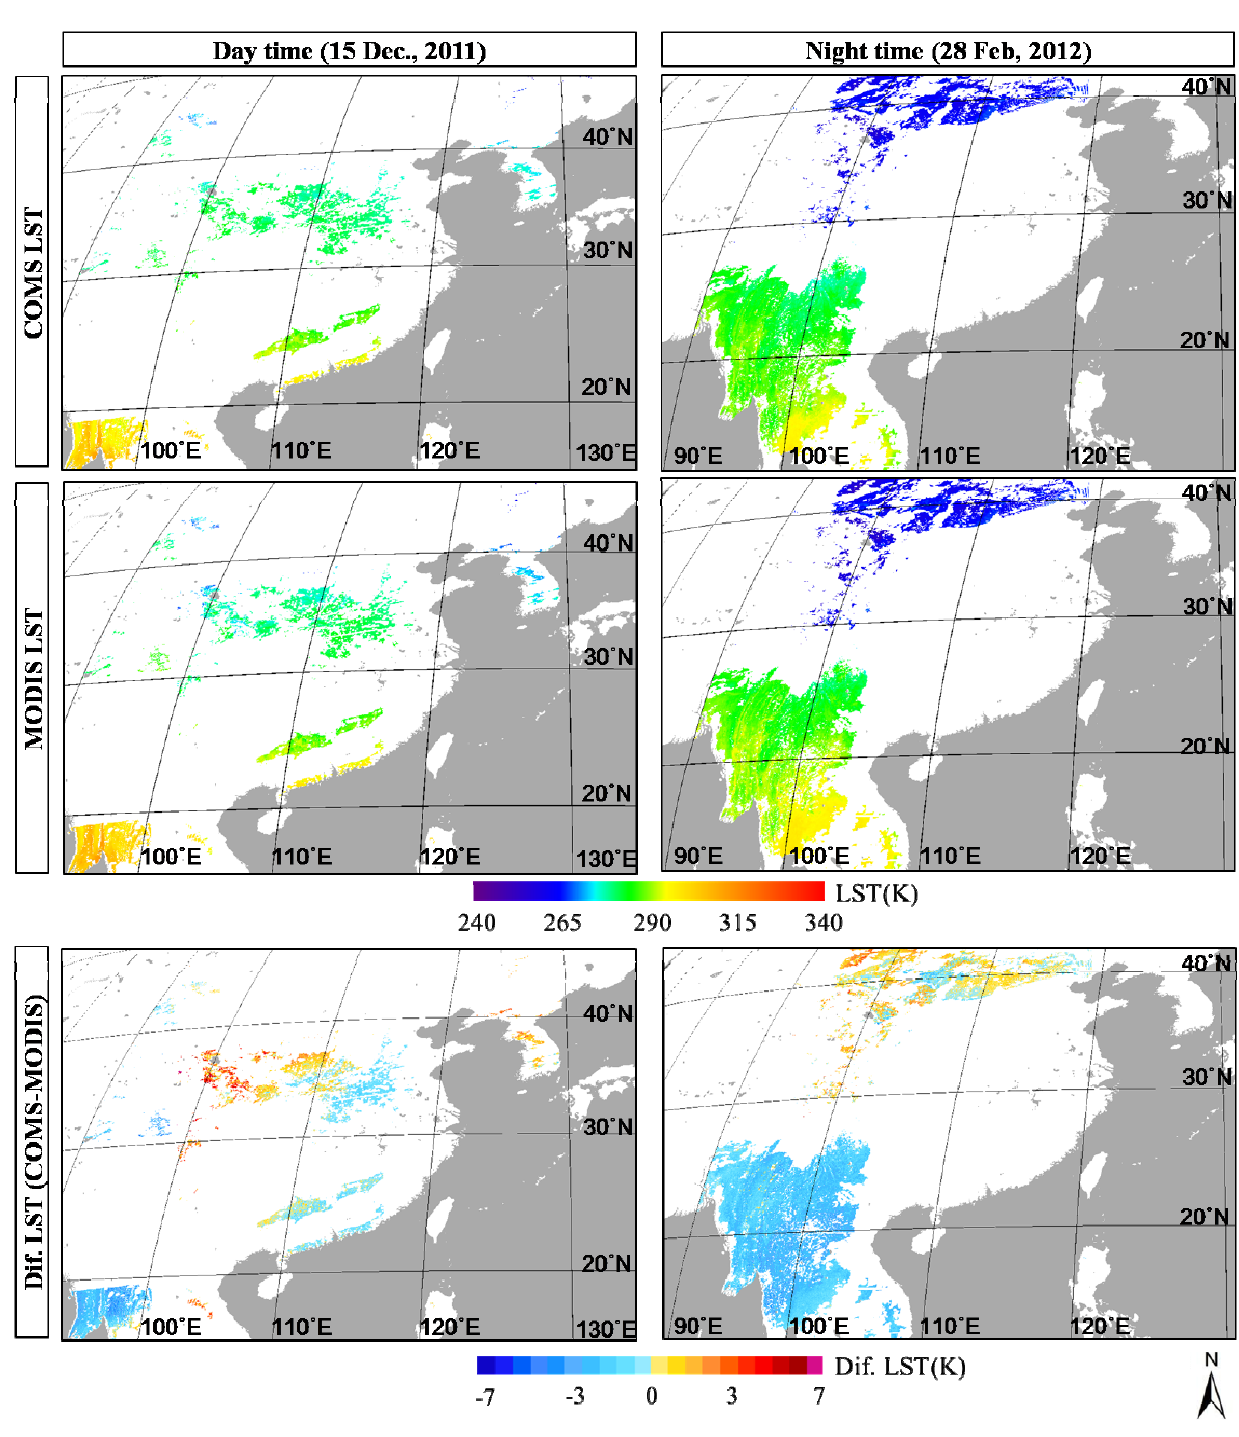
Figure 9. Spatial distribution of COMS LST and MODIS LST data and their differences for two select days during winter (15 December 2011 and 28 February